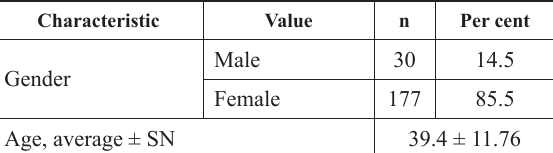
Table 1. Main Demographic Characteristics of Subjects